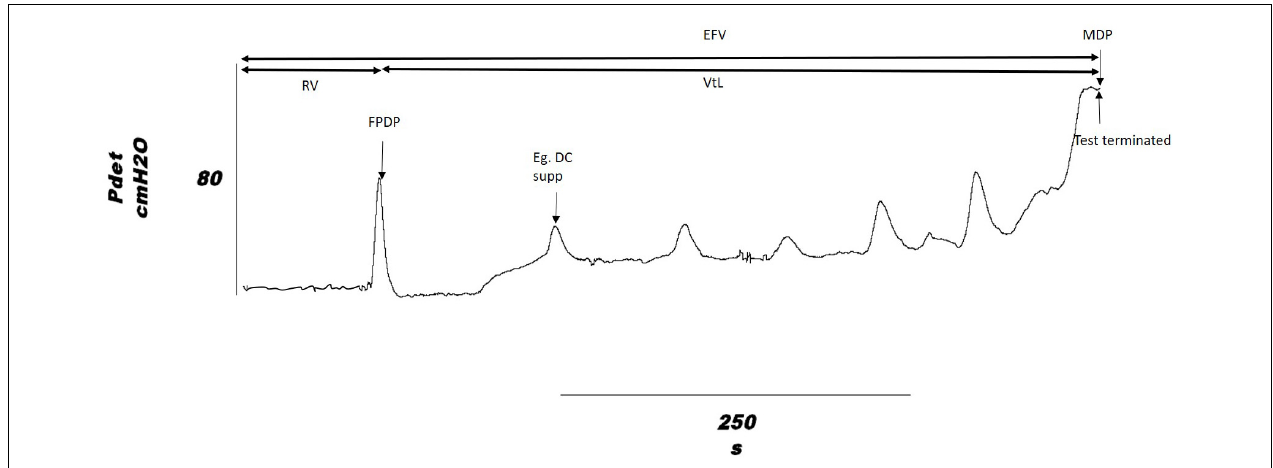
FIGURE 2 | Outcome measures shown on a cystometry detrusor pressure trace, from a DGNS trial fill. Volume infused is taken as the outcome at the time point indicated on the pressure trace for Reflex Volume (RV) and End Fill Volume (EFV). VtL, Volume to Leakage; FPDP, First Peak Detrusor Pressure; MDP, Maximum Detrusor Pressure. An example of a suppressed detrusor contraction is highlighted. TABLE 2 | Stimulation amplitude at sensory and motor thresholds and at maximum tolerable level. DGNS TNS SNS